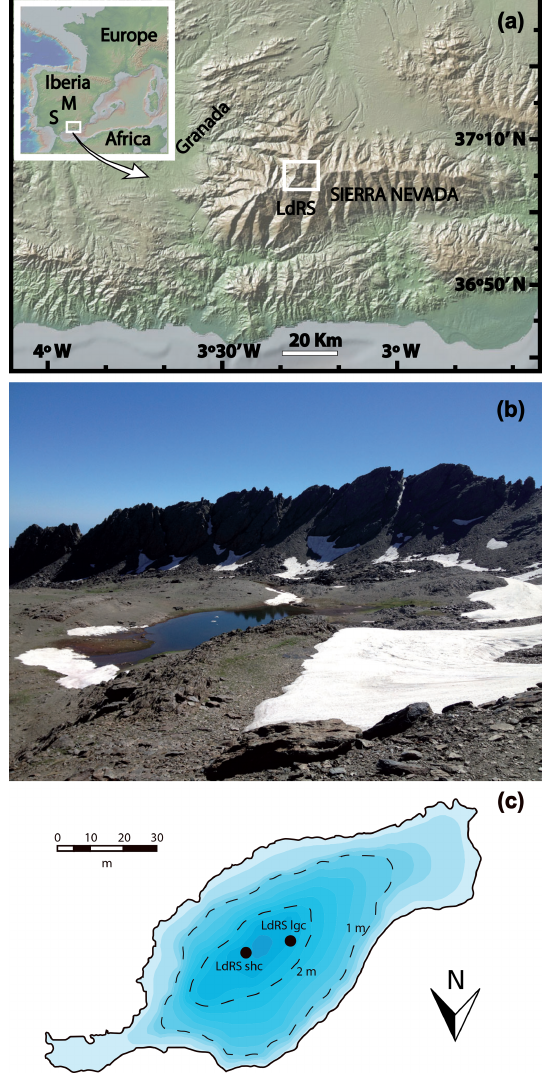
Figure 1. Geographical setting. (a) Location of the Sierra Nevada in the western Mediterranean region: Madrid (M), Seville (S), and Granada observatories, as well as the studied area Laguna de Río Seco (LdRS); (b) LdRS catchment basin (0.42ha) in spring 2013; (c) bathymetry map of LdRS along with the sampling points of both cores. Data source and software: (a) map created by Antonio García-Alix using GeoMapApp (3.6.6) (http://www. geomapapp.org, last access: 19 December 2019); (b) picture from Antonio García-Alix; (c) digitalized map of a bathymetry report from Egmasa